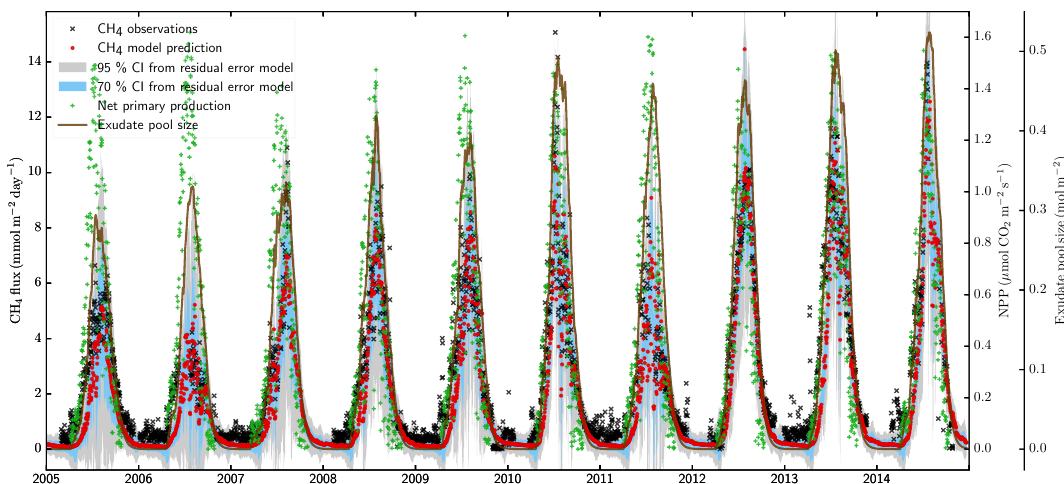
Figure 9. Output CH 4 flux (red dots) with parameters from the posterior mean. Methane observations (black crosses) and predicted fluxes with confidence intervals from ARMA(2,1) modeling of a set of 1000 residual time series are shown, as are the input net primary production (green dots) and the exudate pool sizes (brown line). Most of the observations are inside the confidence intervals, but note that the effects of the parameter variations in the posterior are not part of these confidence intervals. The constituents of the total flux are shown in Fig.